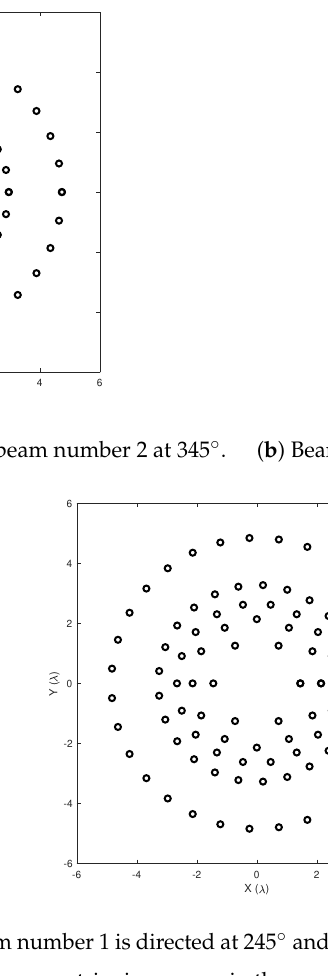
Figure 5. Aperiodic layouts of the concentric ring arrays in the numeric examples while optimizing antenna rings ( (cid:126) r